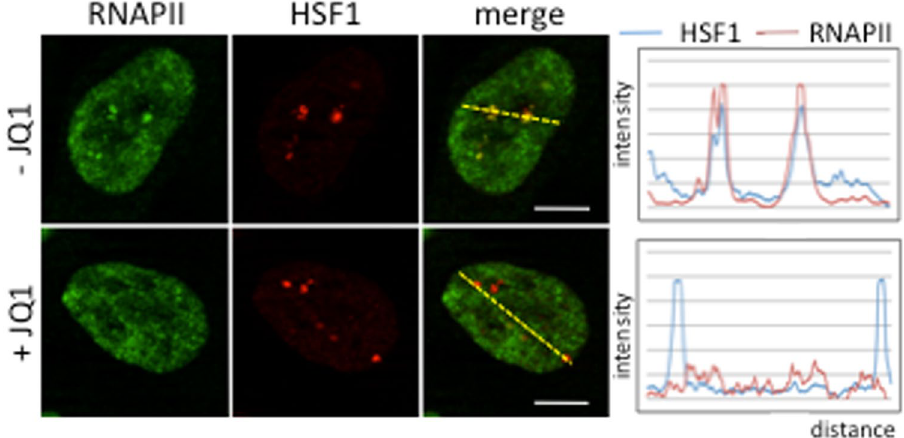
Figure 7. Detection of endogenous HSF1 and RNAP II by immunofluorescence in stressed cells treated or not with JQ1. Colocalization between RNAP II (green signals) and HSF1 (red signals) is > 90% in the absence of JQ1 and < 10% in cells treated with JQ1. Scale bar = 5 µ m.